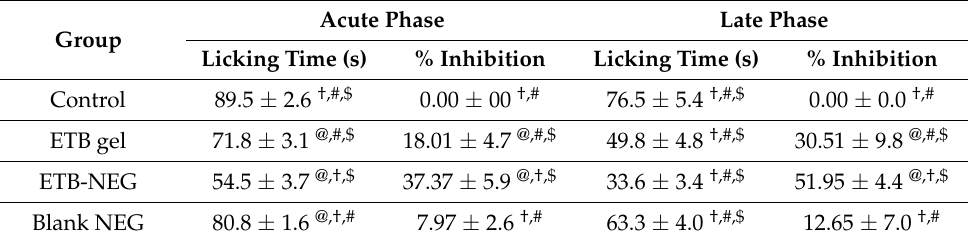
Table 6. Effects of ETB gel, ETB-NEG, and blank NEG in the formalin-induced paw licking test.